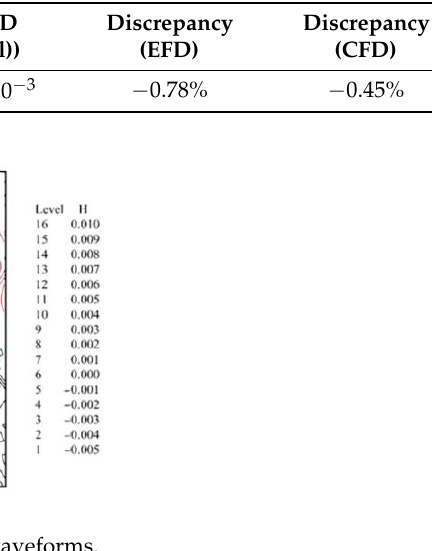
Table 5. KCS simulation results comparison.